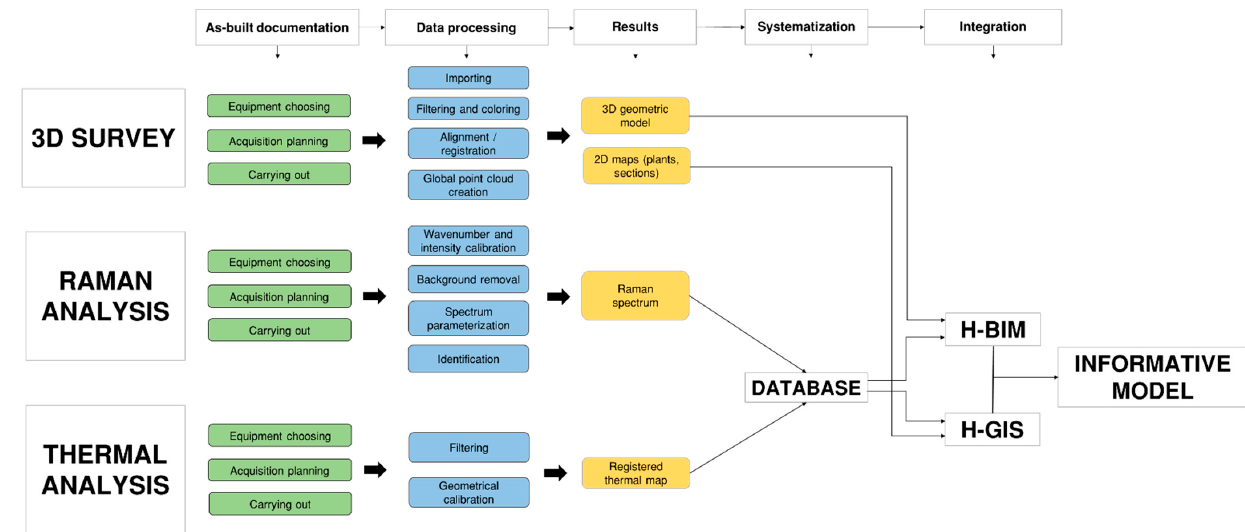
Figure 9. General flowchart.